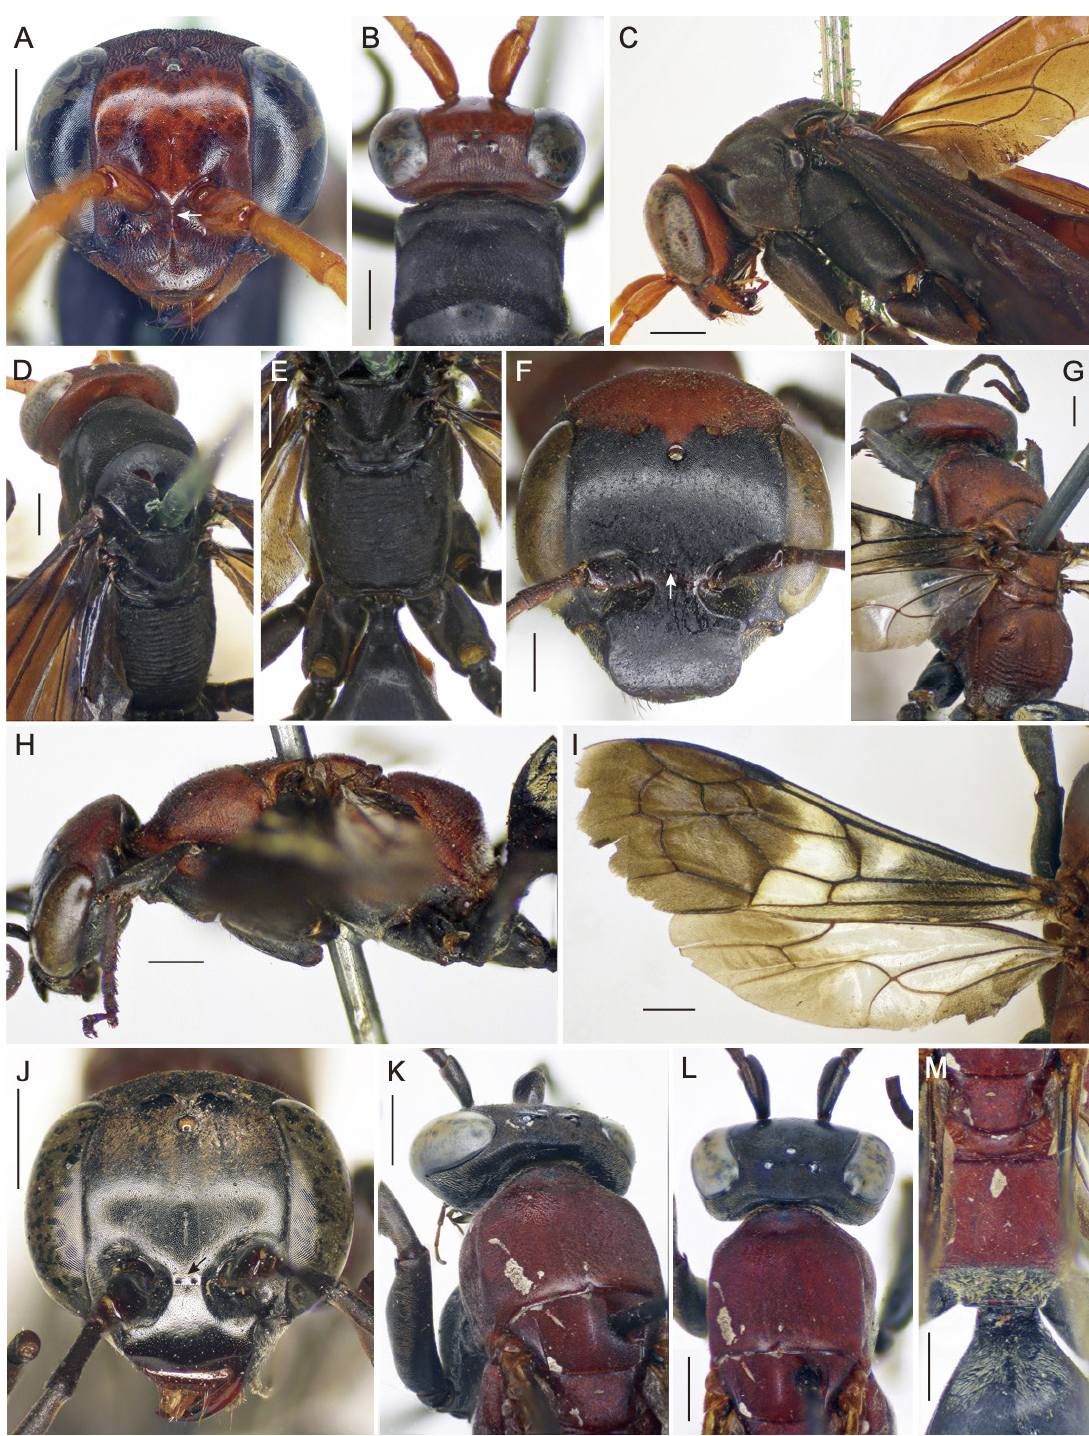
Fig. 1. Females of Ctenocerus Dahlbom, 1845. A–E . C. robustus (Arnold, 1932) (#14) (NHMUK). F–I . C. klugi Dahlbom, 1845 (#8) (NHMUK). J–M . C. fasciatus (Smith, 1851) (#3) (NHMUK). A, F, J . Head, anterior view, arrow indicates frontal bridge. B, L . Head and anterior part of mesosoma, dorsal view. C, H . Head and mesosoma, lateral view. D, G, K . Head and mesosoma, dorsolateral view. E, M . Posterior part of mesosoma and anterior part of metasoma, dorsal view. I . Wings. Numbers in parentheses after species names are specimen numbers in Supp. file 1. Scale bars = 1